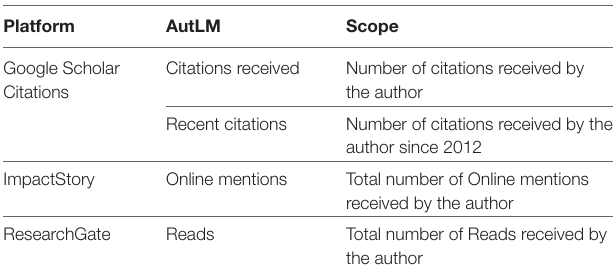
TaBle 1 | Author-level metrics (AutLMs)